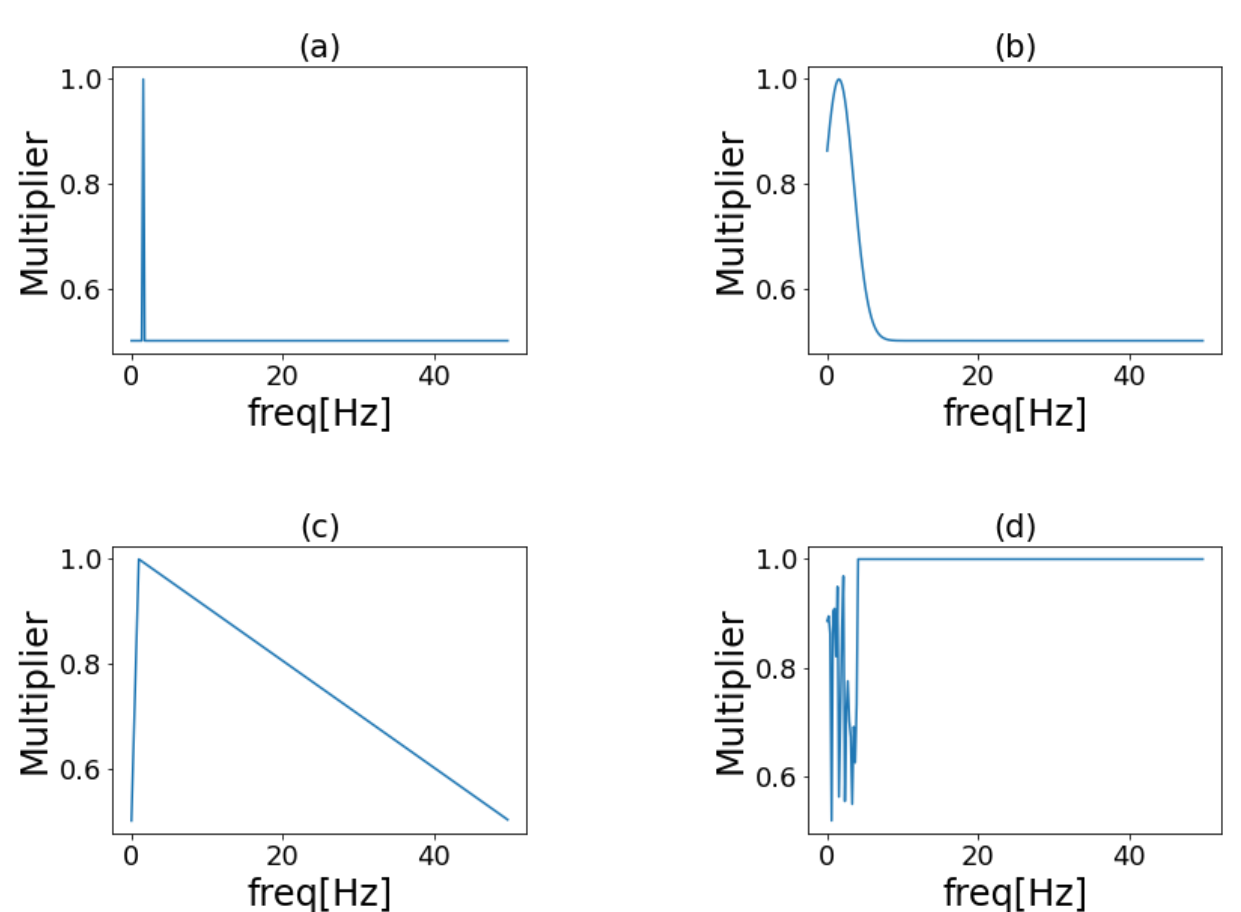
Figure 2. Examples of frequency band enhancement filters. ( a ) Peak window; ( b ) Gaussian window; ( c ) Triangular window; ( d ) Random window.